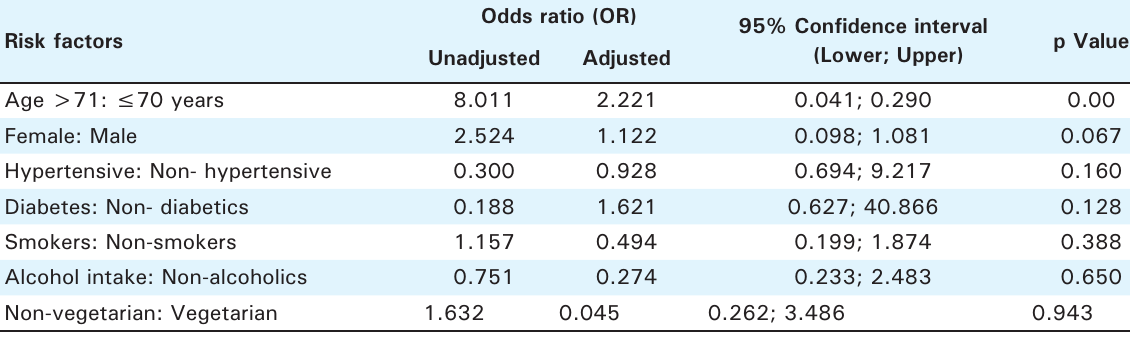
Table 5. Risk factors and Odds ratio in AMD Risk